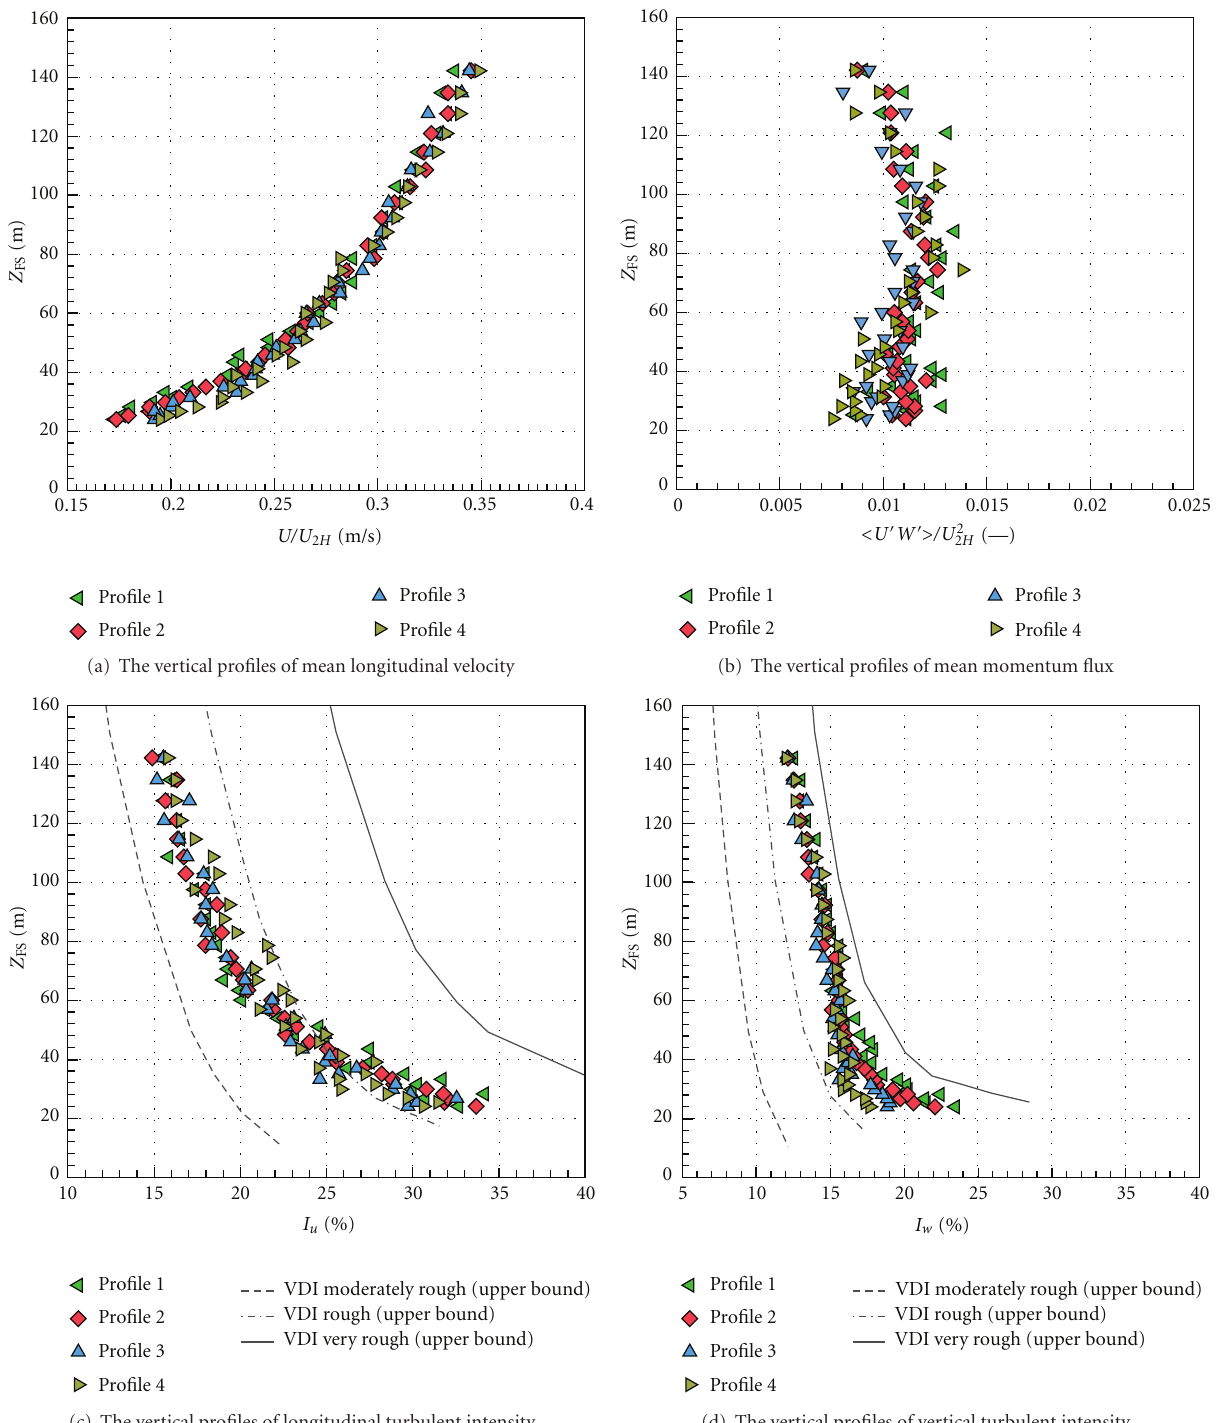
Figure 5: Boundary layer characteristics above the urban area